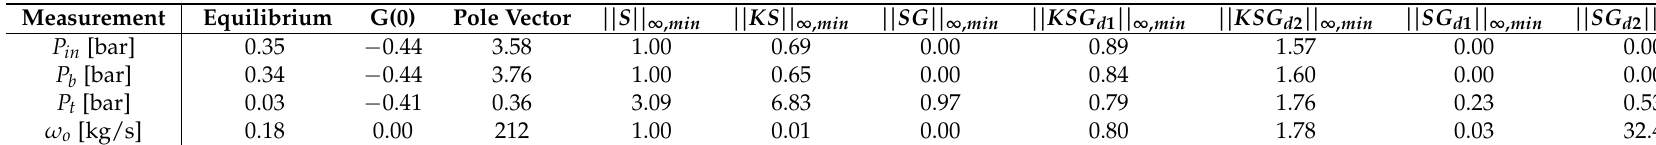
Table 5. Model analysis for Z = 60%.